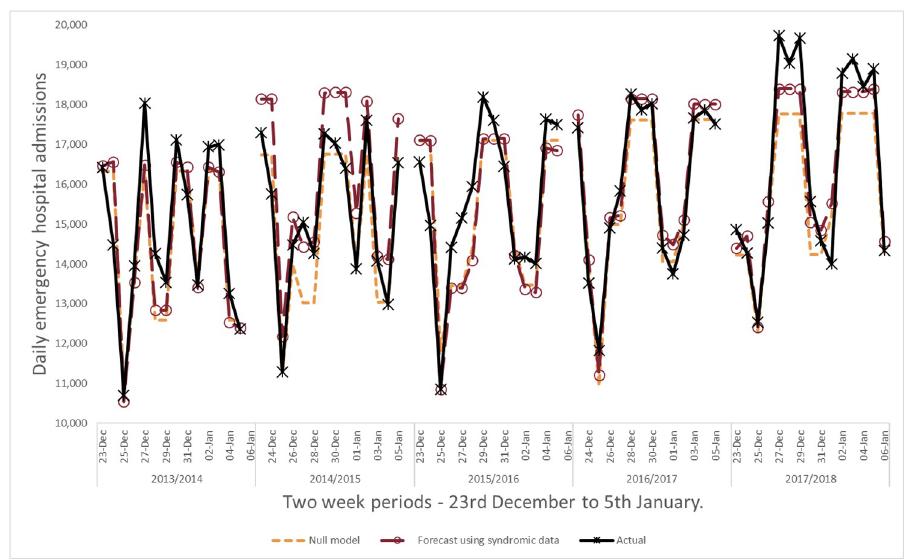
Fig 2. Example forecast using GP consultations for upper respiratory tract infection compared to null forecast model with no syndromic data.